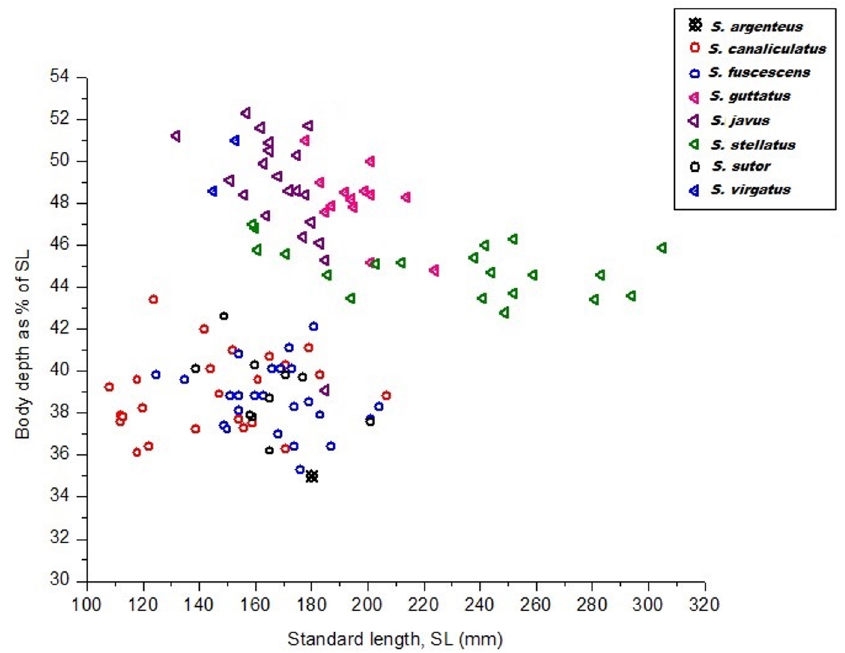
Figure 1. Body depth as a function of the standard length of eight siganid species collected from the South China Sea, Terengganu, Malaysia.